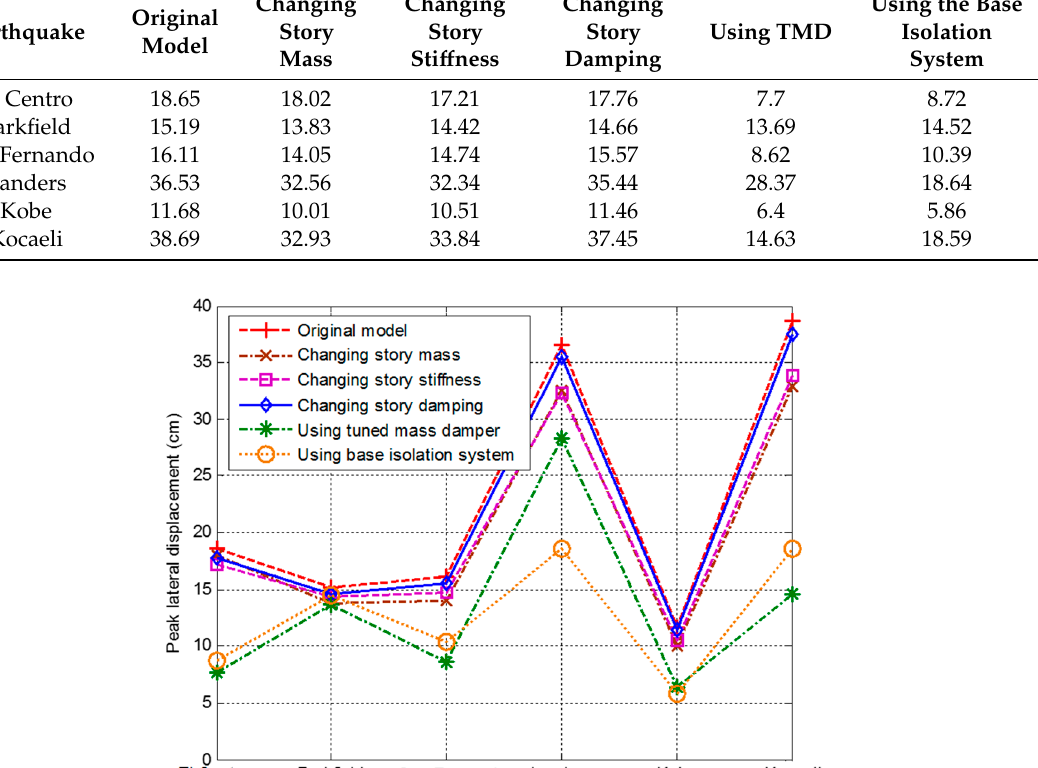
Table 2. Peak relative displacement for the top story of building for di ff erent cases (cm).